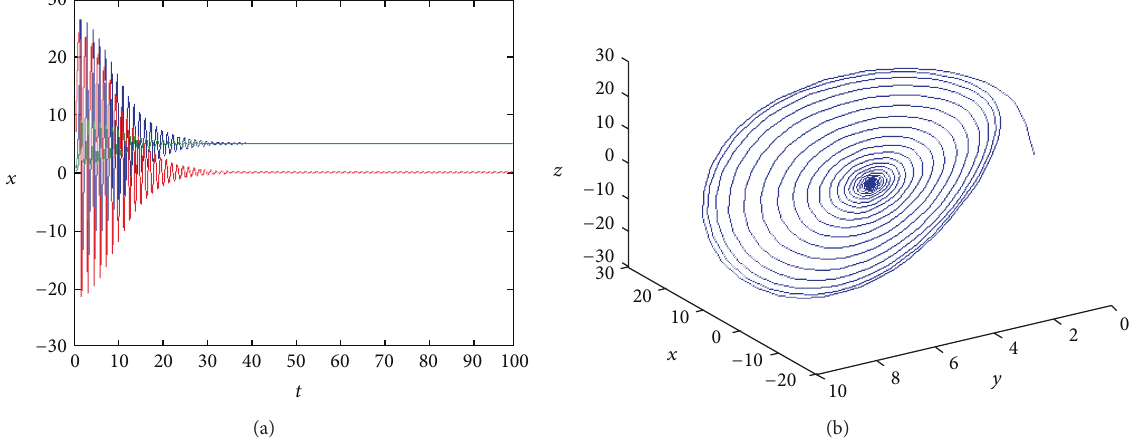
Figure 1: Time history and phase diagram of system (1) with 𝑎 = −1.4 , 𝑏 = 25 .